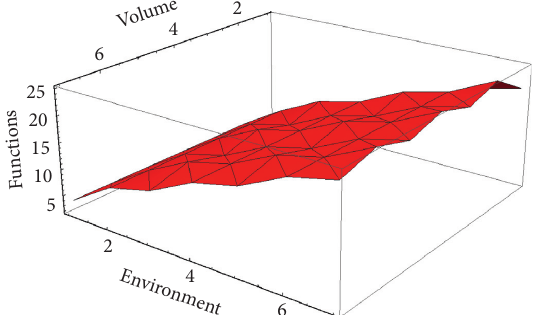
Figure 6: Number of functions over environment thicknesses and volume sizes for rule 128 (Class C). Note the many local maxima.